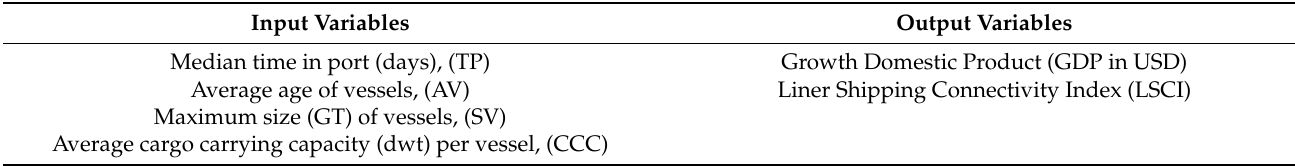
Table 2. Input and output variables of the